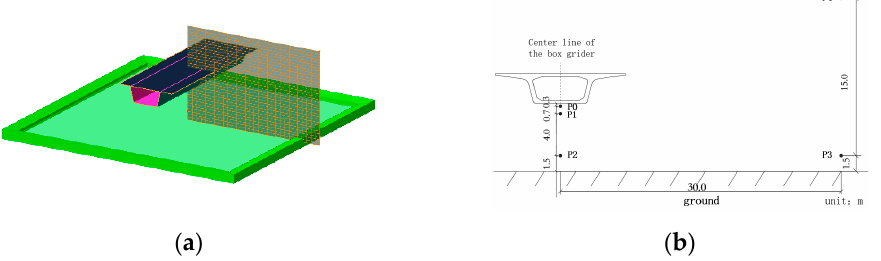
Figure 7. Acoustic boundary element model and field point distribution of box girder; ( a ) acoustic boundary element model for box girder; ( b ) distribution of sound field points in mid-span of bridge.